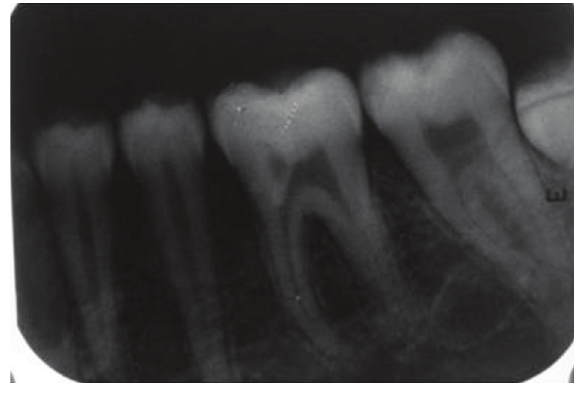
Figure 30: Intraoral periapical radiograph with 36 at 2-year followup. No significant pulpal or periapical changes.